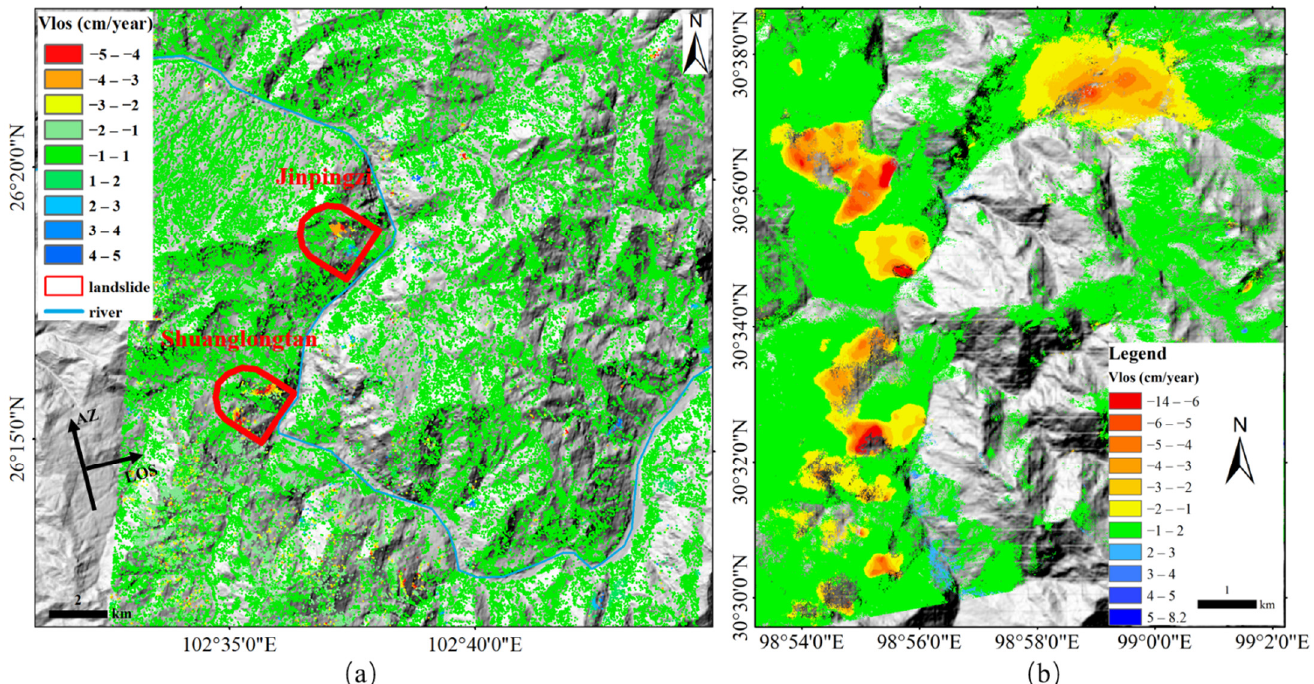
Figure 4. InSAR−derived deformation rate map. ( a ) Deformation rate map in the first small region. The red polygons represent the location of the two potential landslides. ( b ) Deformation rate map in the second large region (validation region).